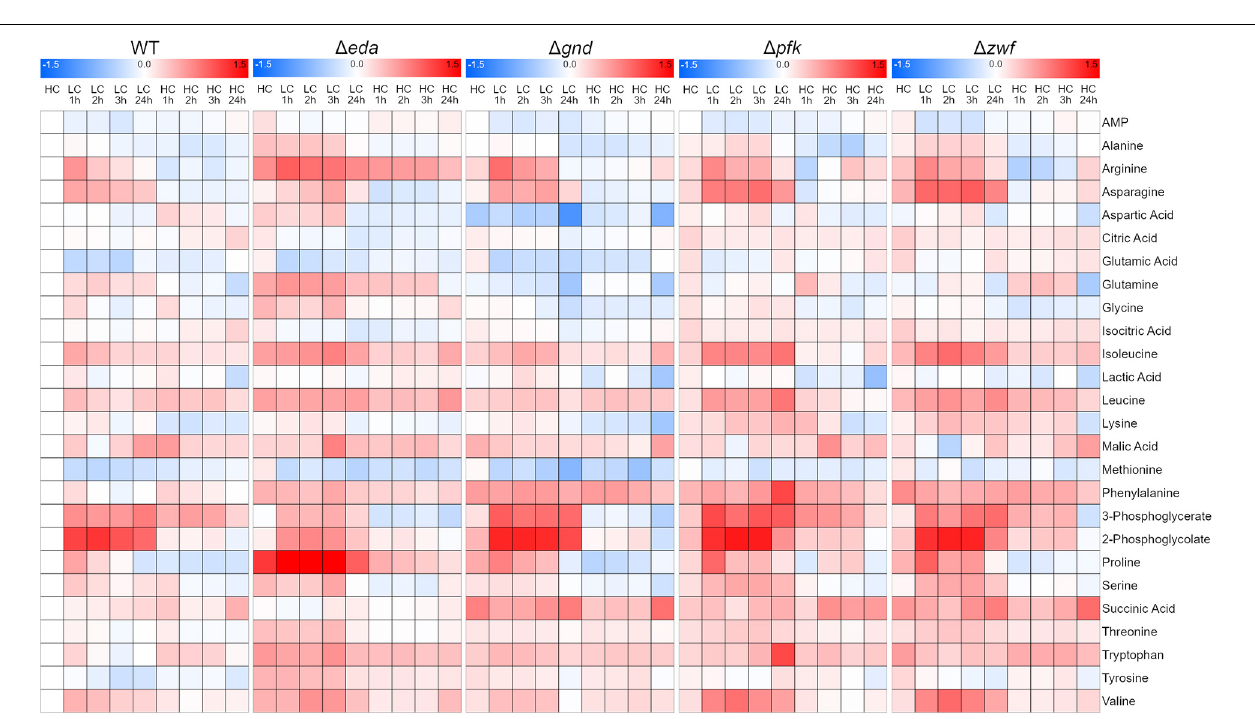
FIGURE 2 | Glycogen pools and growth of the different strains during HC-LC-HC shifts. (A) Glycogen amounts were determined enzymatically. Asterisk indicates significant differences ( p ≤ 0.05) of every single (cid:49) eda value compared with respective wild-type (WT) data. (B) Growth of the different strains during HC-LC-HC shifts. The optical density at 750 nm (OD 750 ) was measured at every sampling point during the shift experiment and is used as proxy for growth ( n = 3). Significant difference ( p ≤ 0.05) between (cid:49) eda and all other strains are marked by an asterisk (representative for three biological replicates).